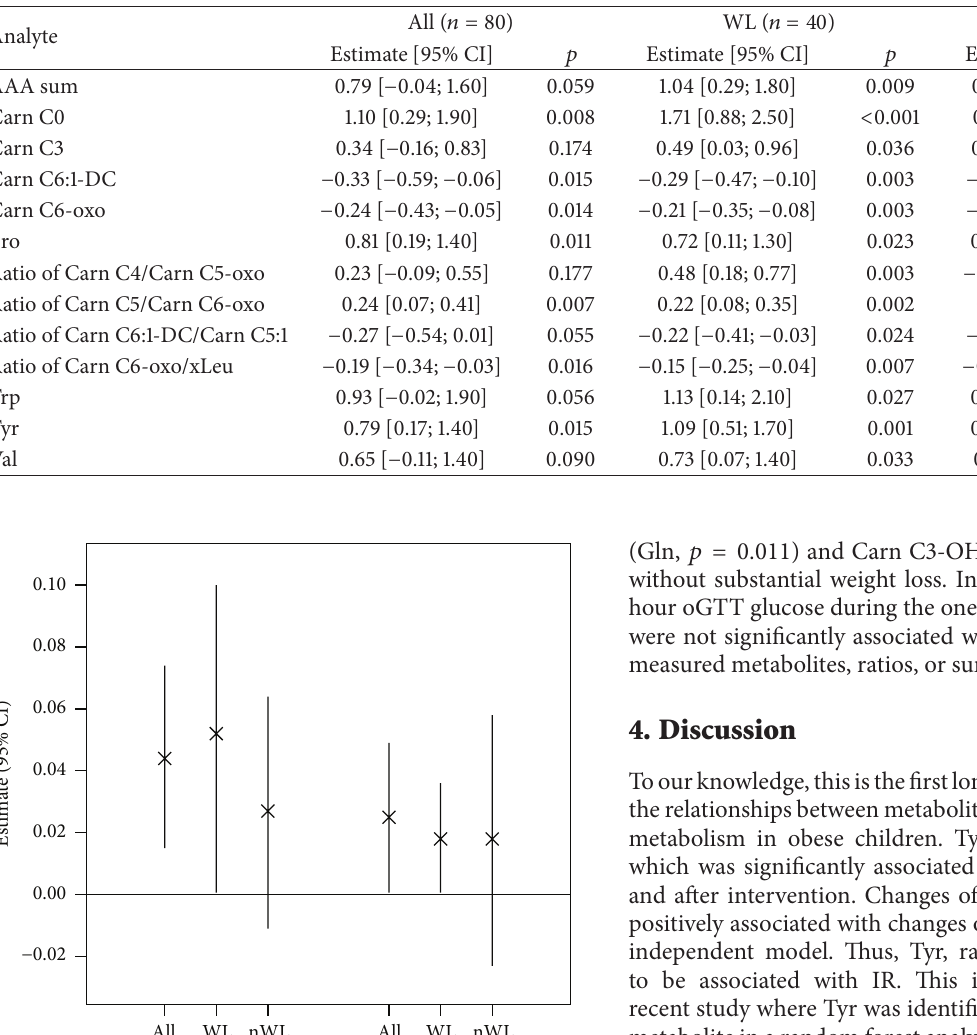
Table 3: Estimates and 𝑝 values ( 𝑝 ) of changes in metabolite concentrations which are significantly associated with changes in HOMA in at least one (sub)group (All, WL, and nWL). Change is defined as the relative change over the one-year intervention. Estimates are given with 95% confidence interval (CI). Estimates, confidence intervals, and 𝑝 values were calculated with robust regression models. WL, children with substantial weight loss; nWL, children without substantial weight loss; AAA, aromatic amino acids; Carn, acylcarnitine; Pro, proline; Trp, tryptophan; Tyr, tyrosine; Val, valine, xLeu, sum of leucine and isoleucine.